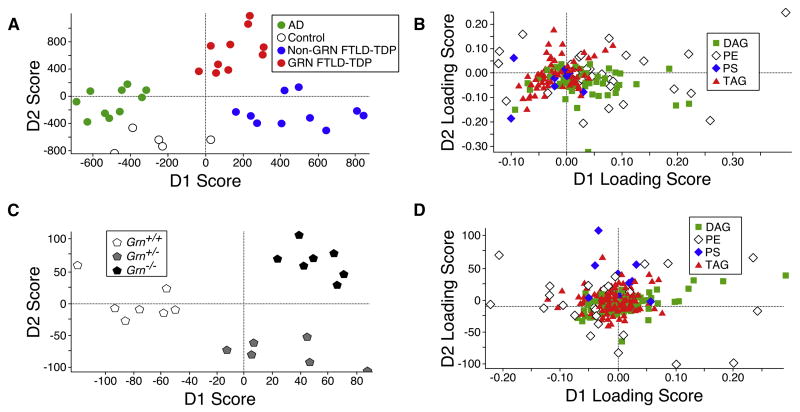
Linear Discriminant Analysis of Lipids Isolated from Pathologic Human Brains and Grn Mutant Mouse Brains(A and B) Fresh frozen post-mortem human cortical tissue from autopsy-confirmed AD, FTLD-TDP with and without heterozygous loss-of-function GRN mutations (GRN FTLD-TDP and non-GRN FTLD-TDP, respectively), and controls (n = 5; Table S1). Lipids were analyzed by infusion-based mass spectrometry (Table S2A). (A) Linear discriminant analysis (LDA) score plots using intensities and mass features of all detected lipids are shown (Table S2B). (B) LDA loading plots of TAGs, DAGs, PSs, and PEs as individual lipid classes in data from human brain samples are shown (Table S2C).(C and D) Fresh frontal cortical tissue from 12-month-old Grn+/+, Grn+/−, and Grn−/− mice (n = 6–7). Lipids were analyzed by infusion mass spectrometry (Table S2D). (C) LDA score plots using intensities and mass features of all detected lipids are shown (Table S2E). (D) LDA loading plots of TAGs, DAGs, PSs, and PEs as individual lipid classes in data from mouse brain samples are shown (Table S2F).